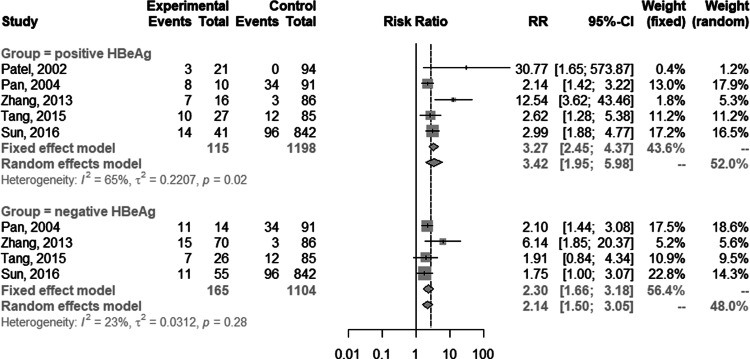
Forest plot of the association between HBV infection with different HBeAg status and the risk of anti-TB DILI.